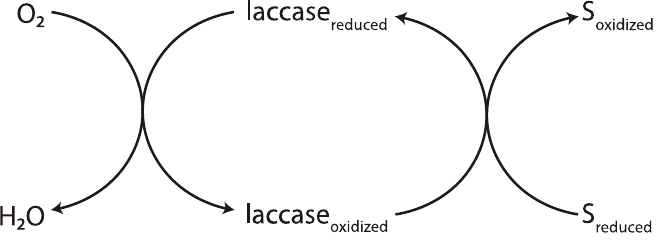
Figure 6. Laccase catalyzes the reduction of oxygen to water by oxidizing an appropriate substrate [59]. Arrows shown reaction direction.